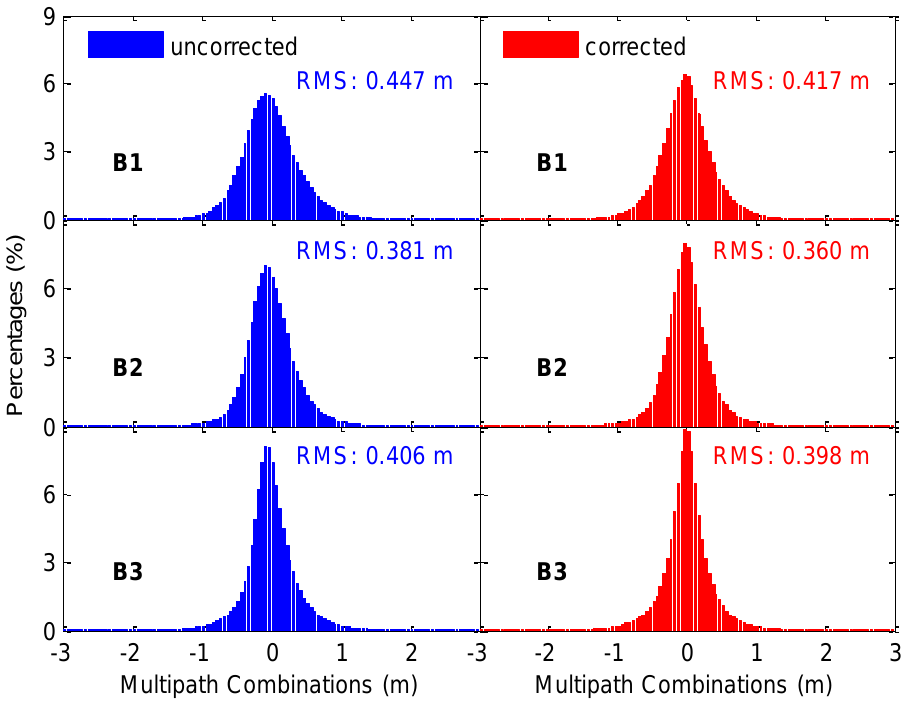
Figure 12. Distribution of uncorrected and corrected MP combination time series for BDS-2 IGSO satellites.